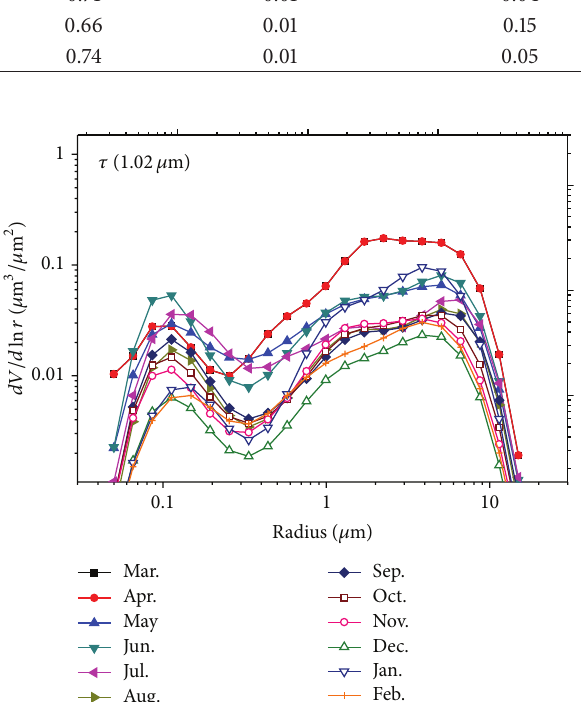
Figure 7: Monthly variation of size distribution of dust aerosols from Mar. 2012 to Feb.